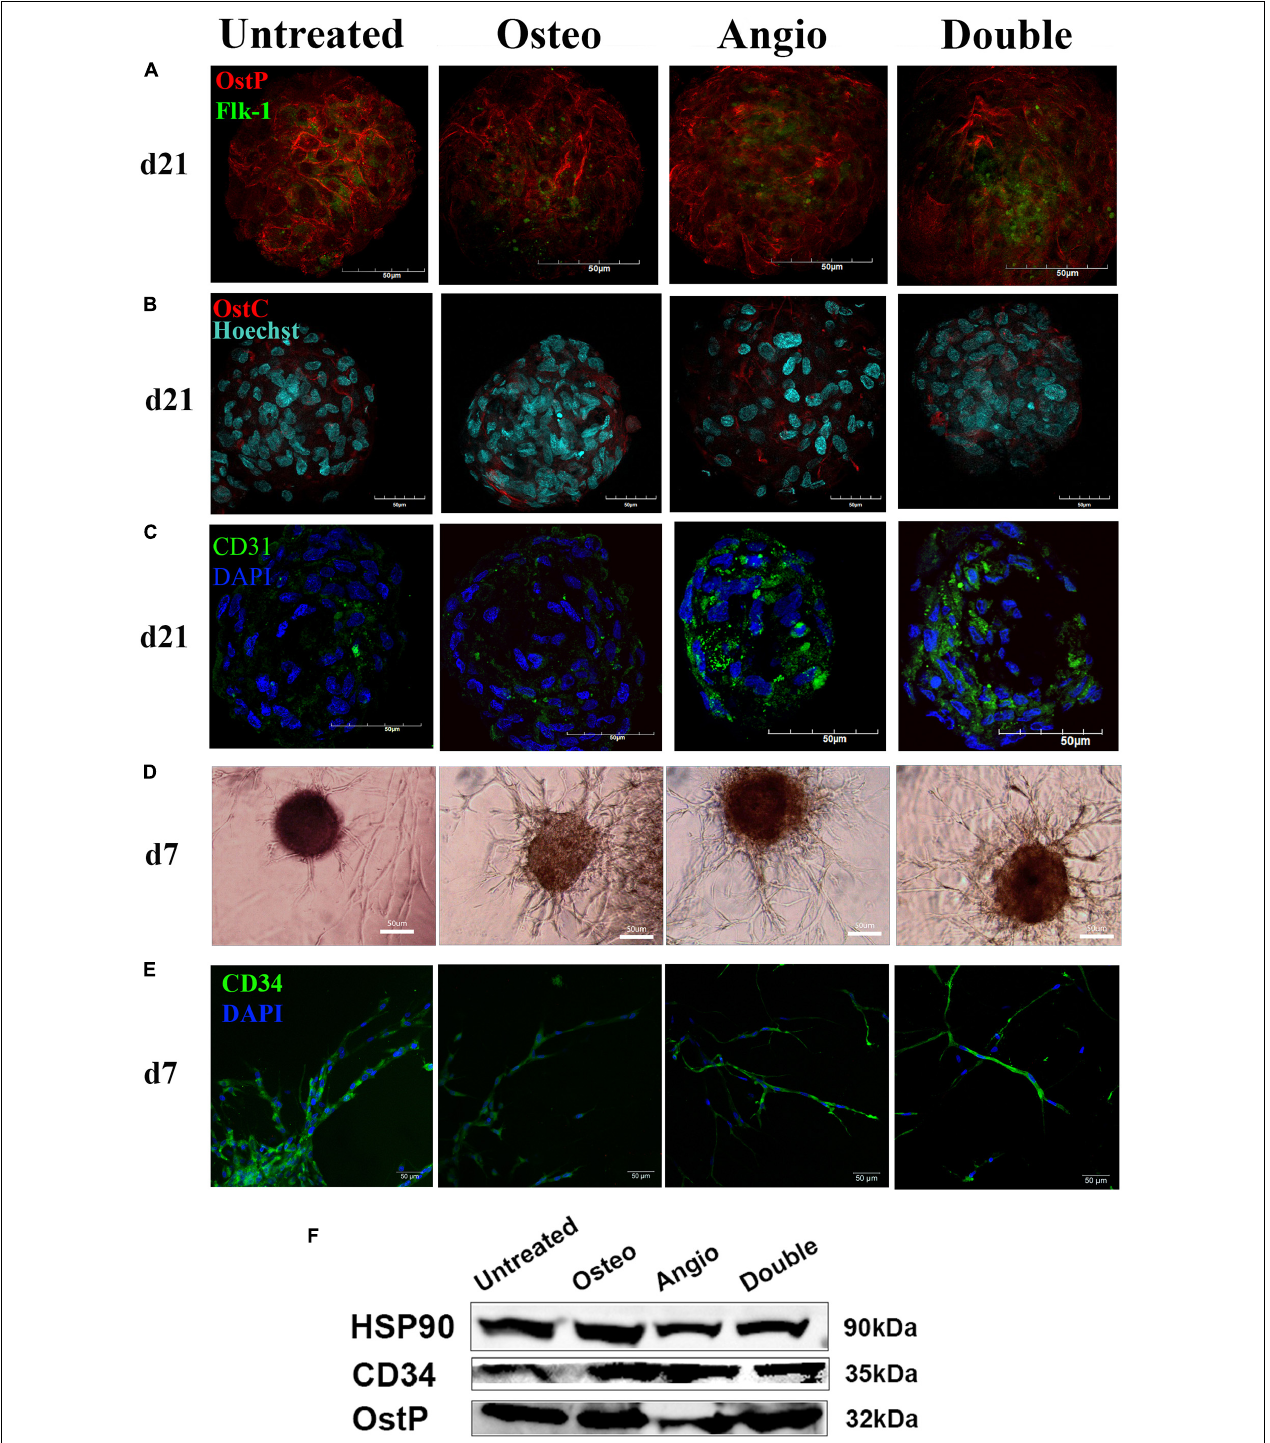
FIGURE 3 | ADSC-derived spheroids showed similar expression of osteogenic (osteopontin, osteocalcin) and endothelial markers (Flk-1, CD31, CD34) with a similar for all groups capacity of angiogenesis in PEGylated fibrin gel. (A) The similar distribution of OstP (red) and Flk-1 (green) in spheroids for all groups on day 21. (B) The similar distribution of OstC (red) in spheroids for all groups on day 21. (C) Spheroids showed expression of PECAM1 (CD31) in all groups on day 21. (D) All groups showed an ability to form tubule-like structures in fibrin gels on day 7. (E) CD34-positive cells migrated from spheroids through fibrin gel and formed tubules on day 7. Laser Scanning Confocal Microscopy, scale bar 50 µ m . Light Phase-Contrast Microscopy, scale bar 50 µ m. (F) Similar expression of osteopontin (OstP) and CD34 compared with the housekeeping protein HSP90 in all groups on day 21 (blots were cropped and presented).